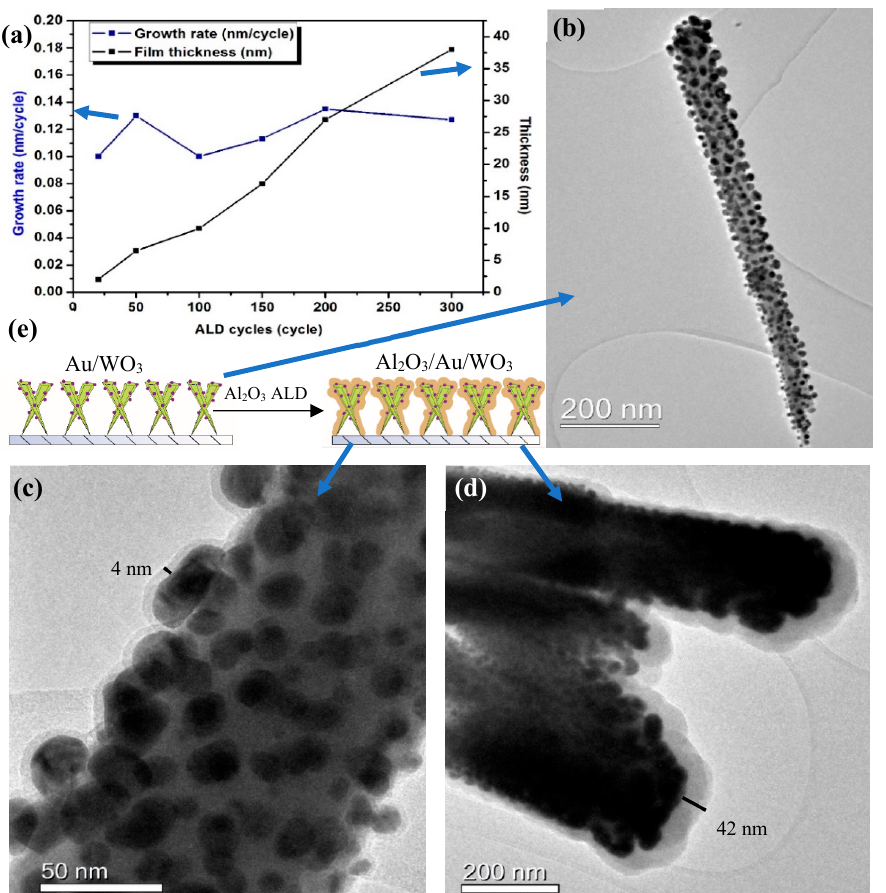
Figure 8. ( a ) Al 2 O 3 film growth rate (blue) and film thickness (black) as a function of reaction cycles, ( b ) Au / WO 3 structure, ( c ) Au / WO 3 with 50 cycles ALD Al 2 O 3 growth on top, ( d ) Au / WO 3 with 300 cycles ALD Al 2 O 3 growth on top, ( e ) Schematic procedure of ALD Al 2 O 3 growth.